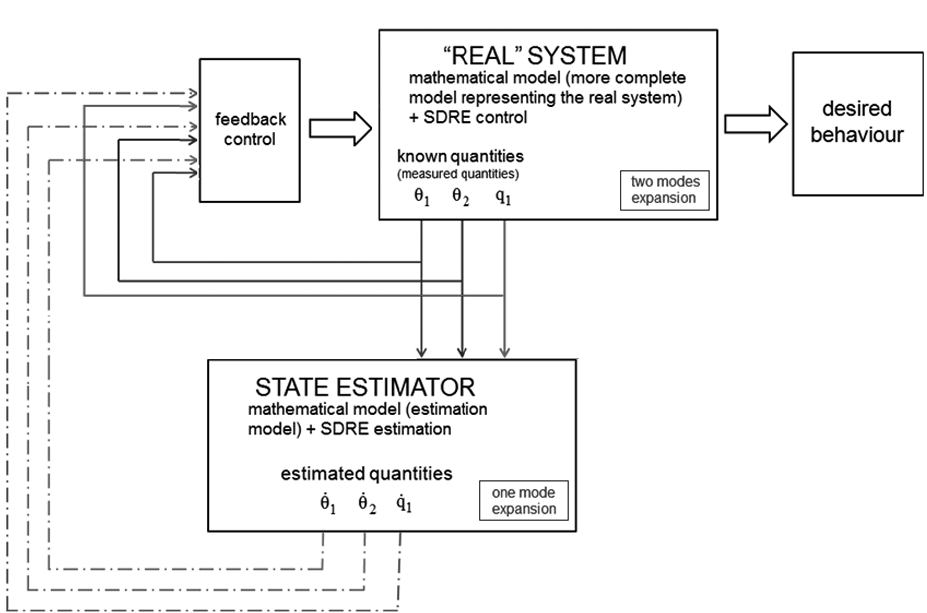
Fig. 2. The general idea for nonlinear control and nonlinear estimation using